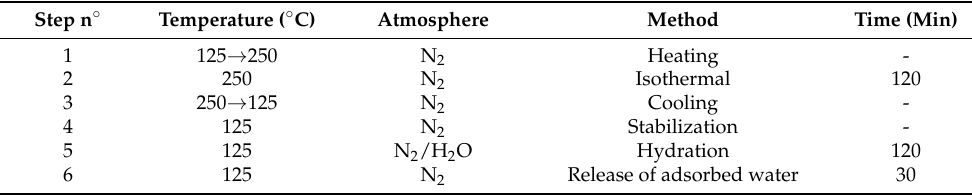
Table 3. Schematization of a single thermogravimetric